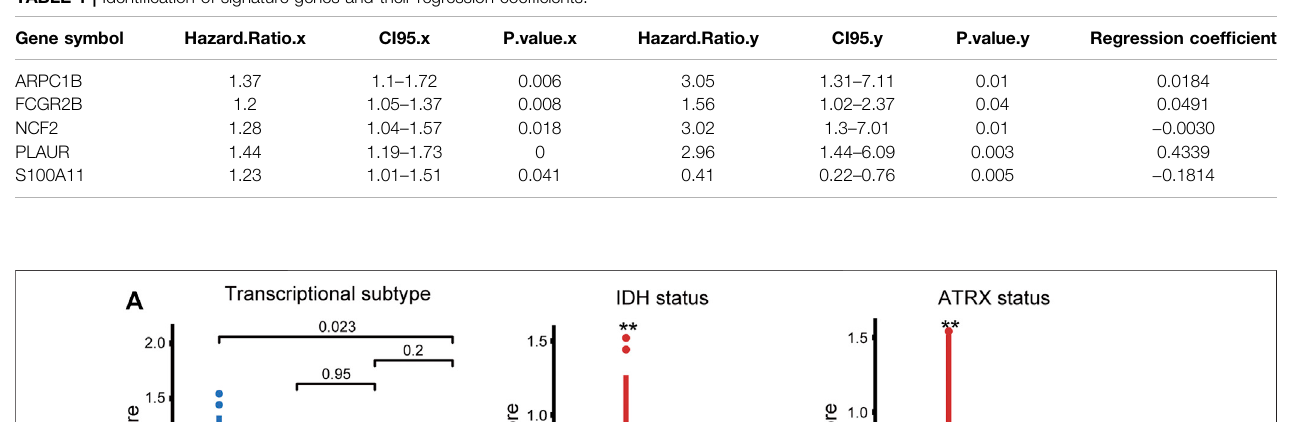
the risk score for different populations was determined.